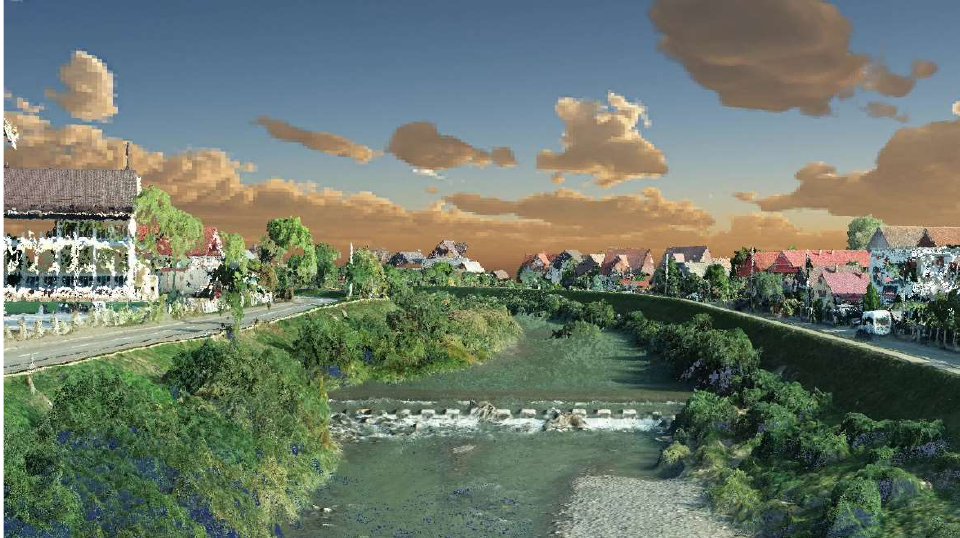
Figure 4. The 3D image at the weir created using the clouds of points obtained from measurements with the professional drone.